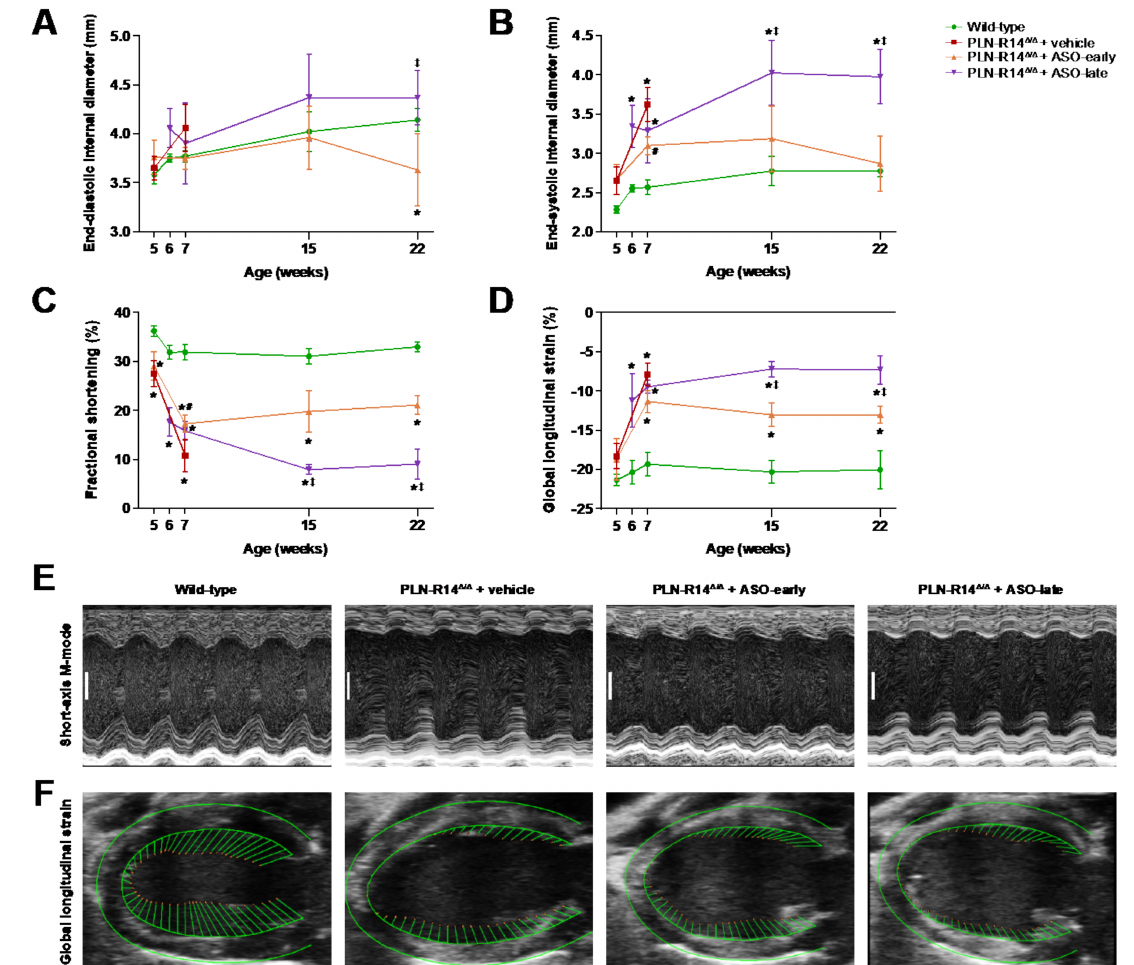
Figure 2. Heart failure progression was halted by PLN-ASO treatment. ( A - D ) Left-ventricular end-diastolic ( A ) and end-systolic ( B ) internal diameters, percentage fractional shortening ( C ) and percentage global longitudinal strain ( D ) at the age of 5, 6, 7, 15 or 22 weeks in WT mice and PLN-R14 ∆ / ∆ mice subjected to vehicle or early or late PLN-ASO administration ( n = 6 per group, except n = 4 for 5-, 6- and 7-week-old WT mice and 7-, 15- and 22-week-old ASO-late mice). Data including individual values are shown in Figure S2. Data are shown as mean ± SD. * p < 0.05 vs. age-matched WT mice, # p < 0.05 vs. age-matched PLN-R14 ∆ / ∆ + vehicle, ‡ p < 0.05 vs. age-matched PLN-R14 ∆ / ∆ + ASO-early (two-way ANOVA followed by Tukey’s post hoc test). Data of 5- to 7-week-old WT mice are derived from Eijgenraam et al. [15]. ( E ) Images of short-axis M-mode recordings of 7-week-old WT mice and PLN-R14 ∆ / ∆ mice receiving vehicle or early or late PLN-ASO treatment, representative for the data shown in ( A – C ) (scale bar: 1 mm). ( F ) Representative long-axis B-mode images of 7-week-old WT mice and PLN-R14 ∆ / ∆ mice receiving vehicle or early or late PLN-ASO treatment including left-ventricular epicardial and endocardial tracings with vectors indicating the direction and magnitude of wall motion, which is quantified in ( D ) (scale bar: 1